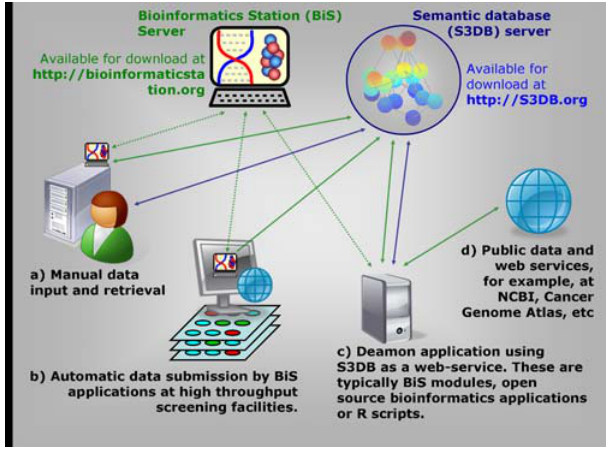
Figure 6. Prototype infrastructure for integrated data man- agement and analysis being tested by the Univ. Texas Lung cancer SPORE. The system is based on two components, a network of universal semantic database servers and a code distribution server that delivers applications in response to the use of ontology. Four distinct user cases are represented, a–d, which rely on a combination of download of interpreted code (green arrows) or direct access to web- based graphic user interfaces or web-based API (blue arrows, in the latter case using Representational State Transfer, REST). The dotted lines represent regular updating of the application, propagating improve- ments in the application code.